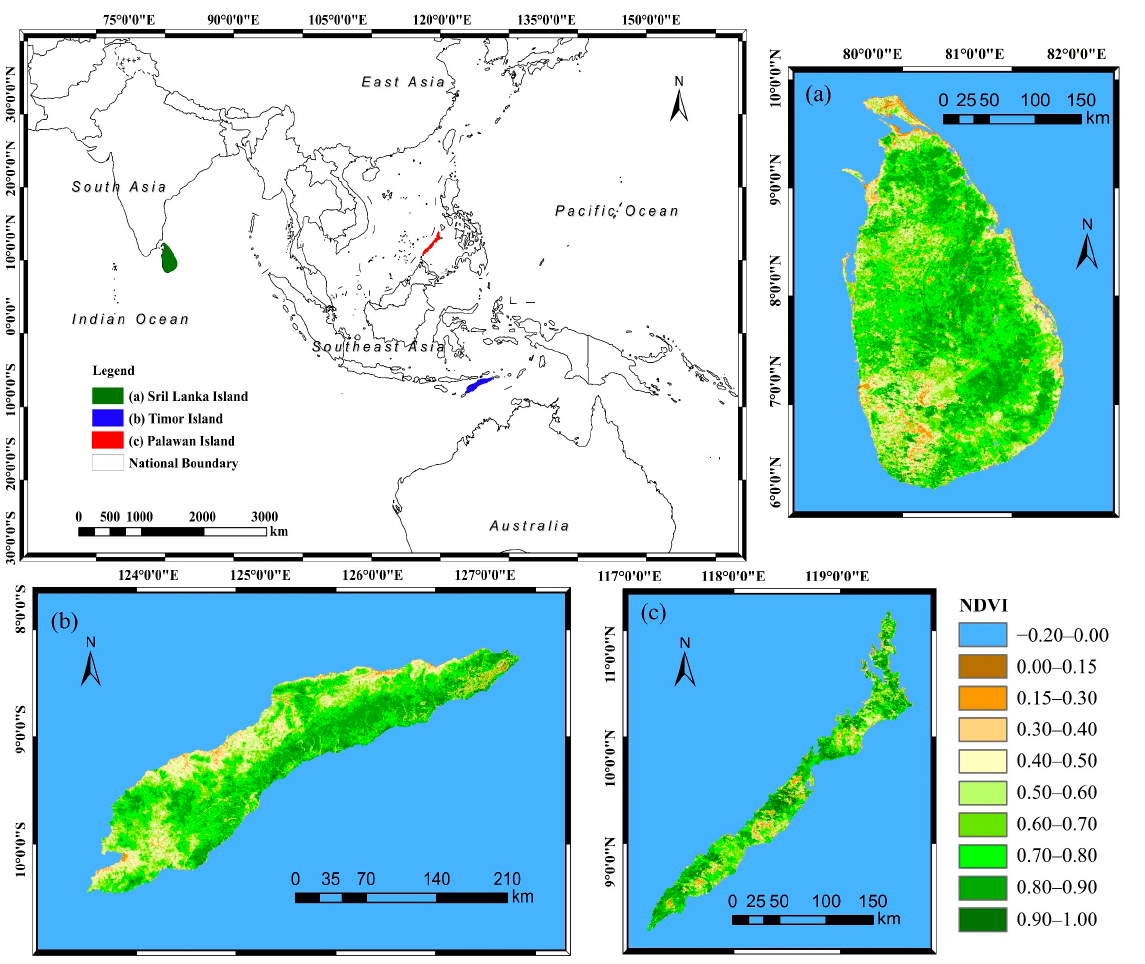
Figure 1. Location map of the study areas. ( a ) Sri Lanka Island, ( b ) Timor Island, and ( c ) Palawan Island. The background map is the normalized vegetation index map derived from MOD13Q1 in 2020.